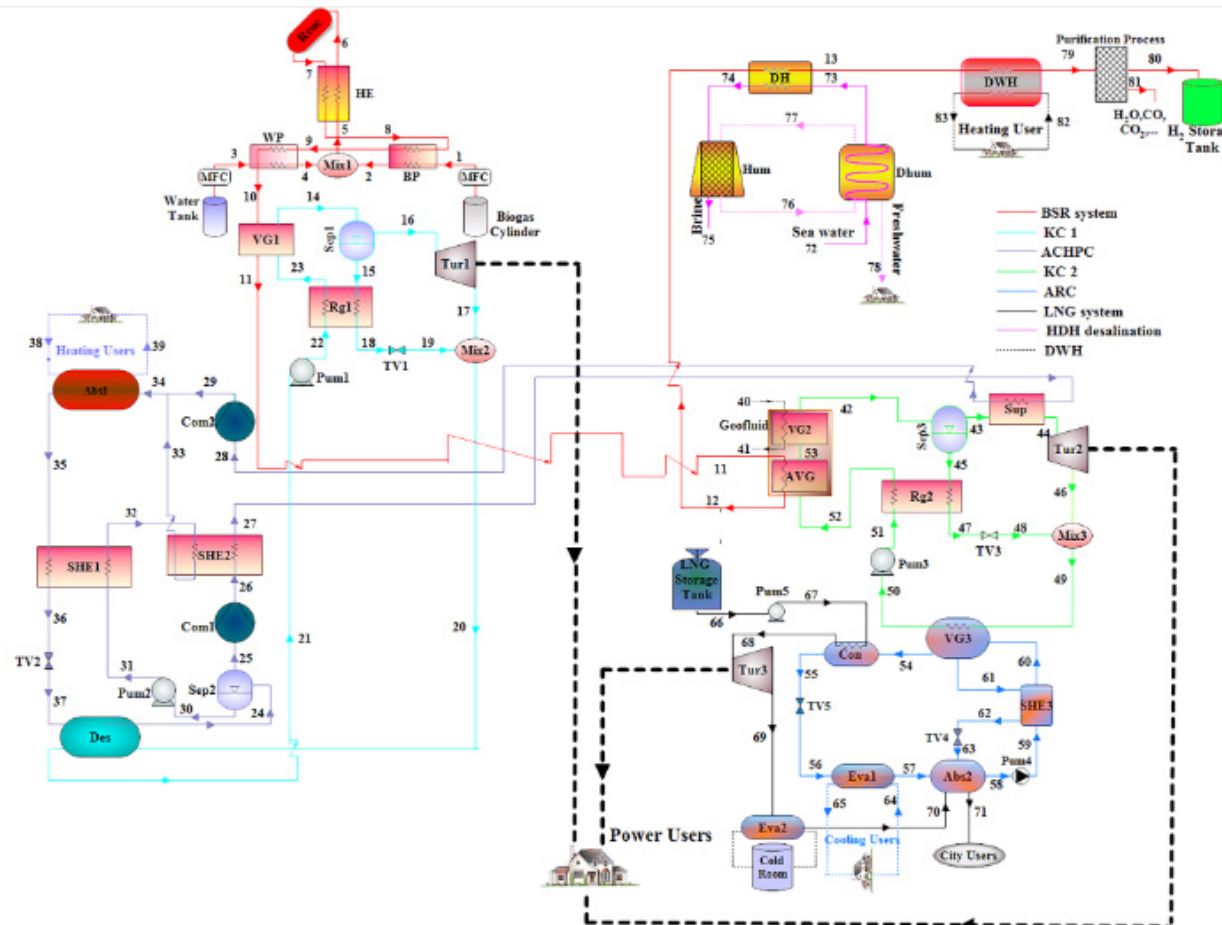
Figure 15. Biogas–geothermal hybrid renewable energy system [172].